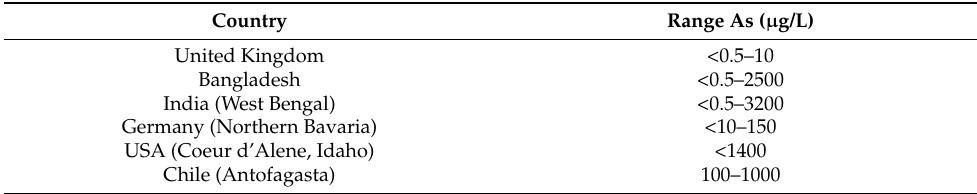
Table 1. Arsenic level in groundwater in different geographical locations